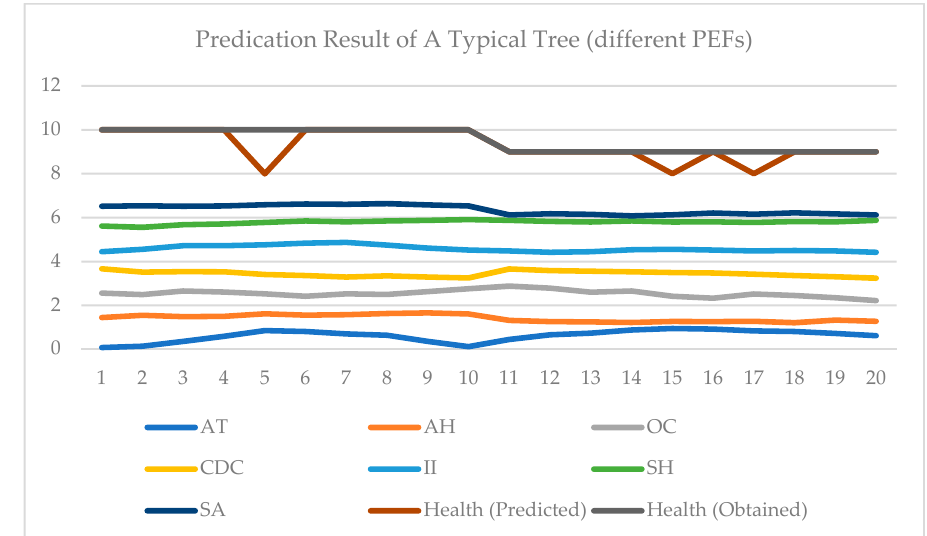
Figure 6. Prediction results of a typical tree (different PEFs).